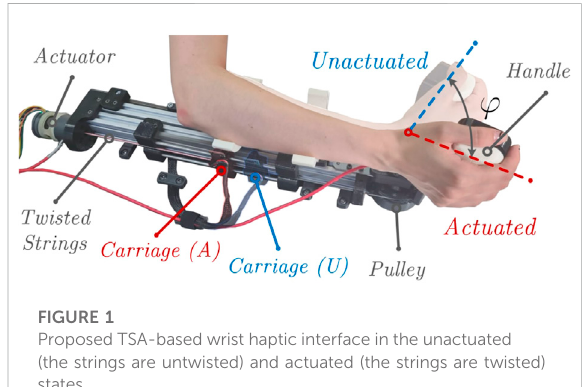
FIGURE 1 Proposed TSA-based wrist haptic interface in the unactuated (the strings are untwisted) and actuated (the strings are twisted) states. FIGURE 2